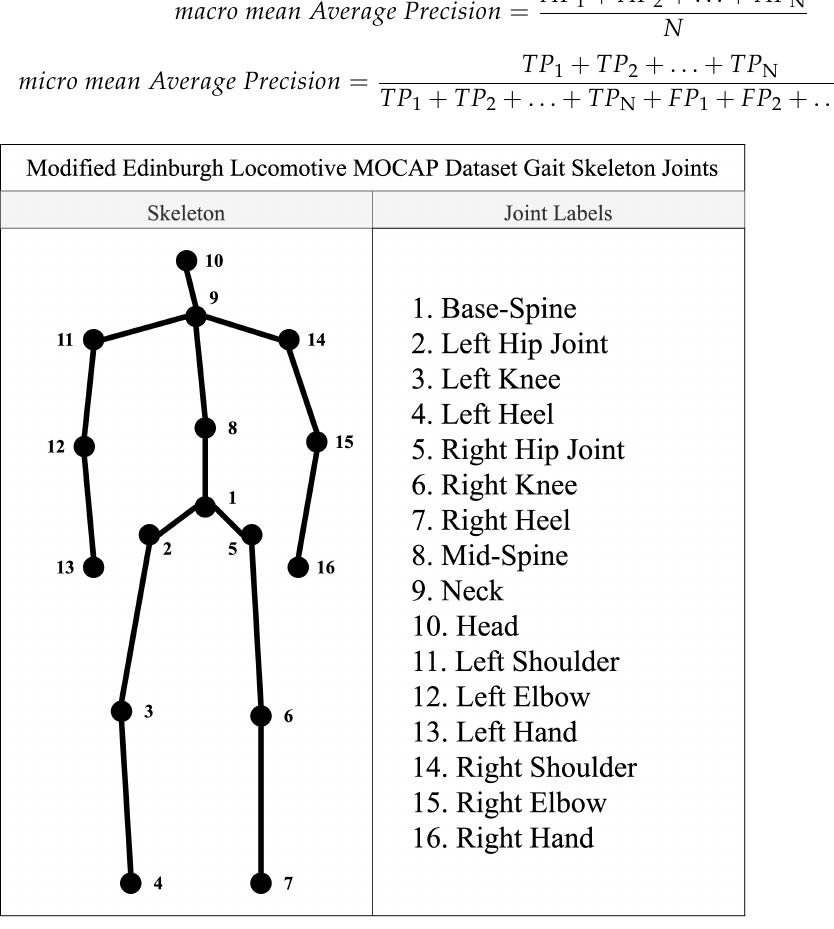
Figure 2. Modified body skeleton from Edinburgh Locomotive MOCAP Dataset.